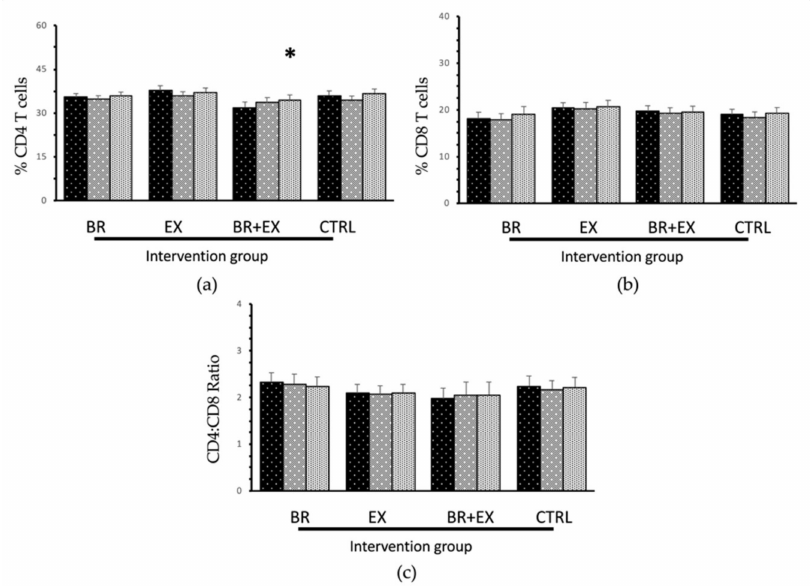
Figure 3. Changes in immunosenescence biomarkers in all 4 di ff erent intervention groups during the 24-week intervention period: ( a ) %CD4 + T cells; ( b ) %CD8 + T cells; ( c ) CD4 + / CD8 + T cell ratio. (data were expressed as mean ± SE, BR = Black rice germ and bran alone group, EX = Exercise alone group, BR + EX = Combined group and CTRL = Control group). * p < 0.05 vs. baseline with statistical significance using repeated measured